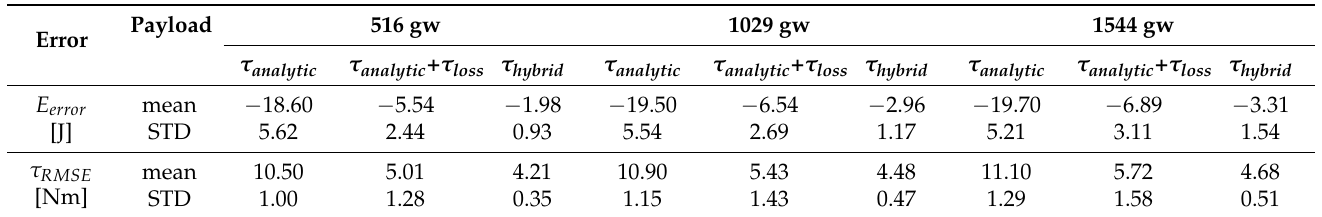
Table 2. The energy consumption discrepancy and joint root mean square error (RMSE) torque between the empirical manipulator and the models with different payloads.